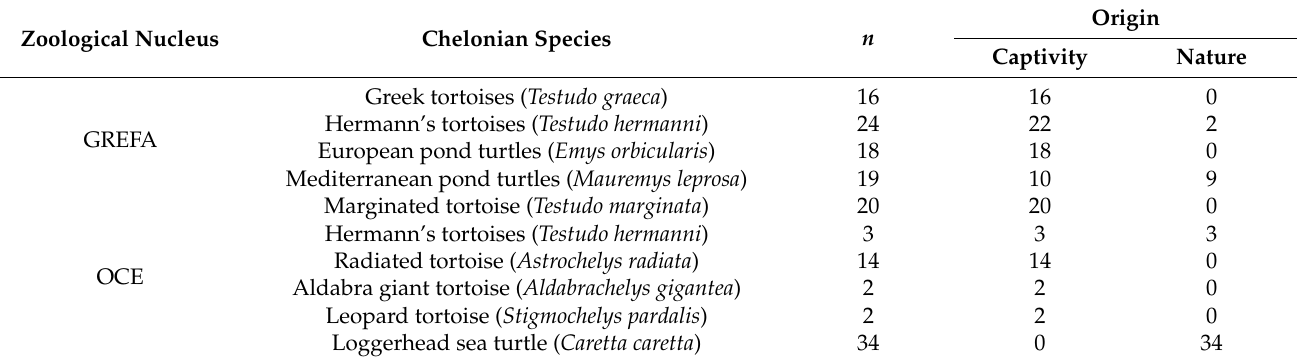
Table 1. Species, origin details of chelonians sampled in this